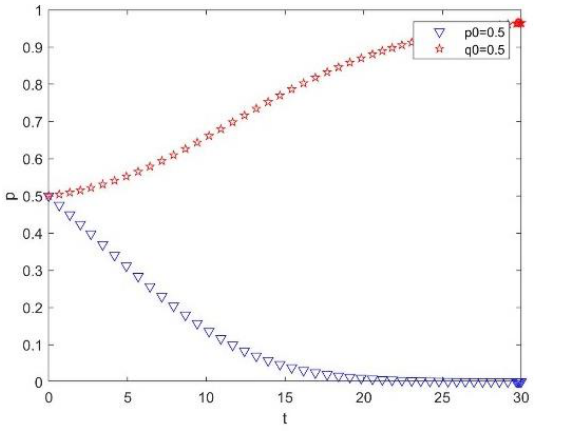
Figure 1. System dynamic evolution diagram.